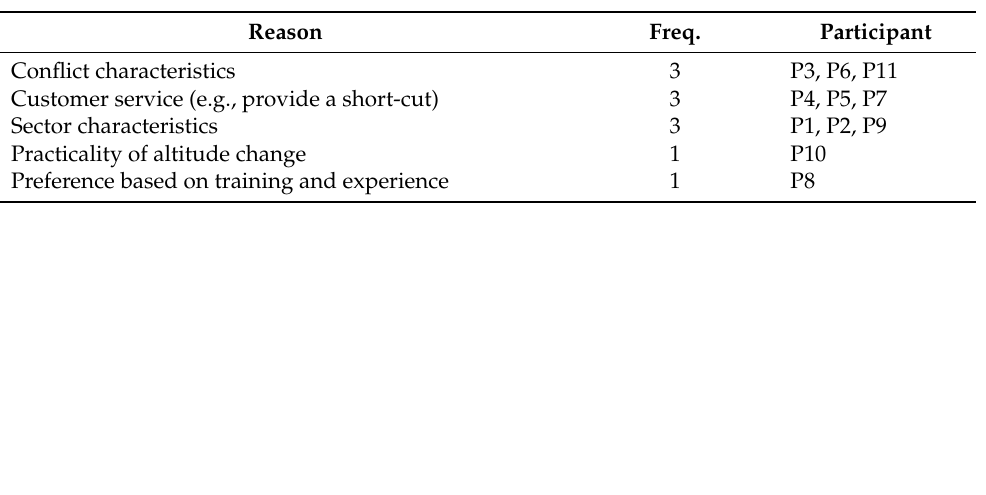
Table 11. Reason for preferred conflict mitigation